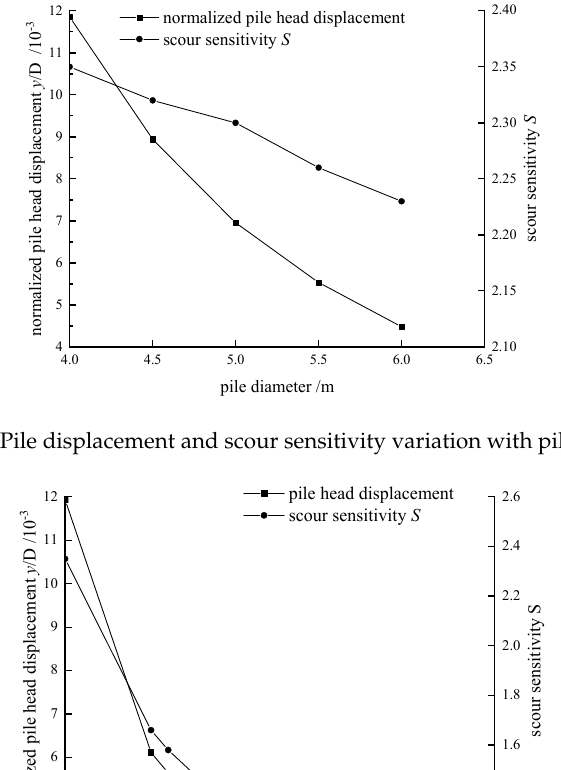
Figure 16. Pile displacement and scour sensitivity variation with pile diameter.